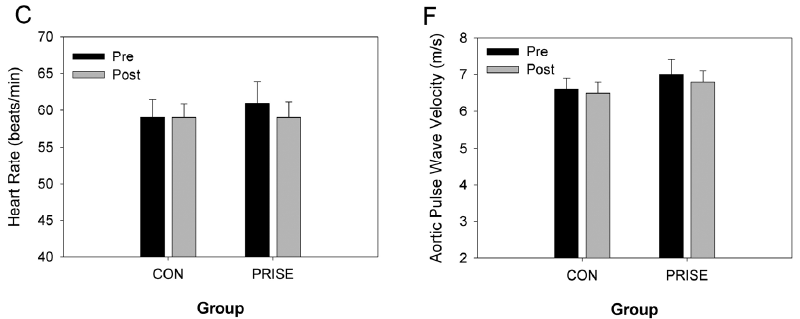
Figure 3. Cardiovascular responses to 12 weeks of PRISE and CON. * p < 0.05 pre vs. post training, # p < 0.05 group difference in training response. CON, normal protein; PRISE, protein ‐ pacing. Mean ± SD.